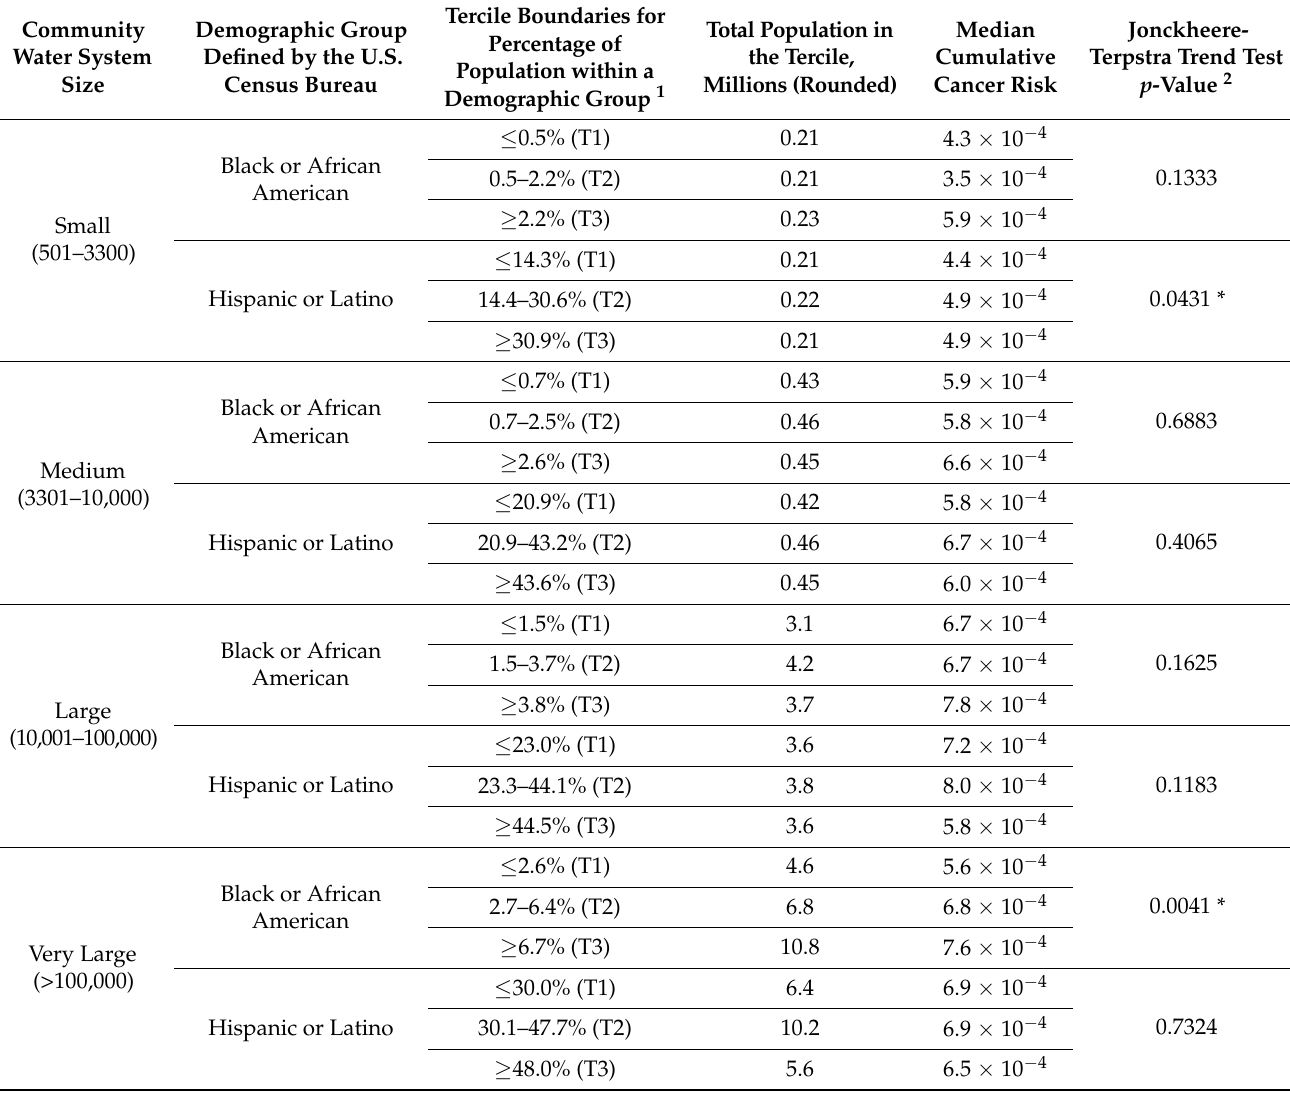
Table 2. Cumulative cancer risk for community water systems in California grouped by system size.